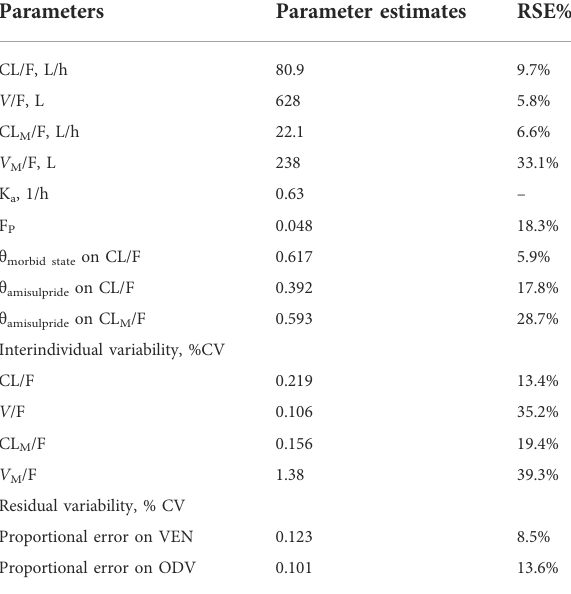
TABLE 2 Pharmacokinetic parameters for the joint PPK model of VEN and